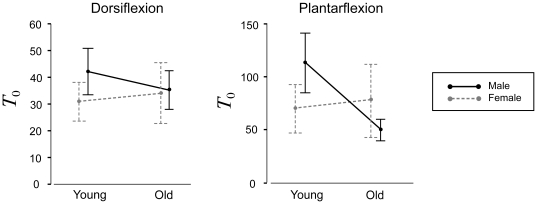
Interaction plots for maximal isometric torque (T
0).